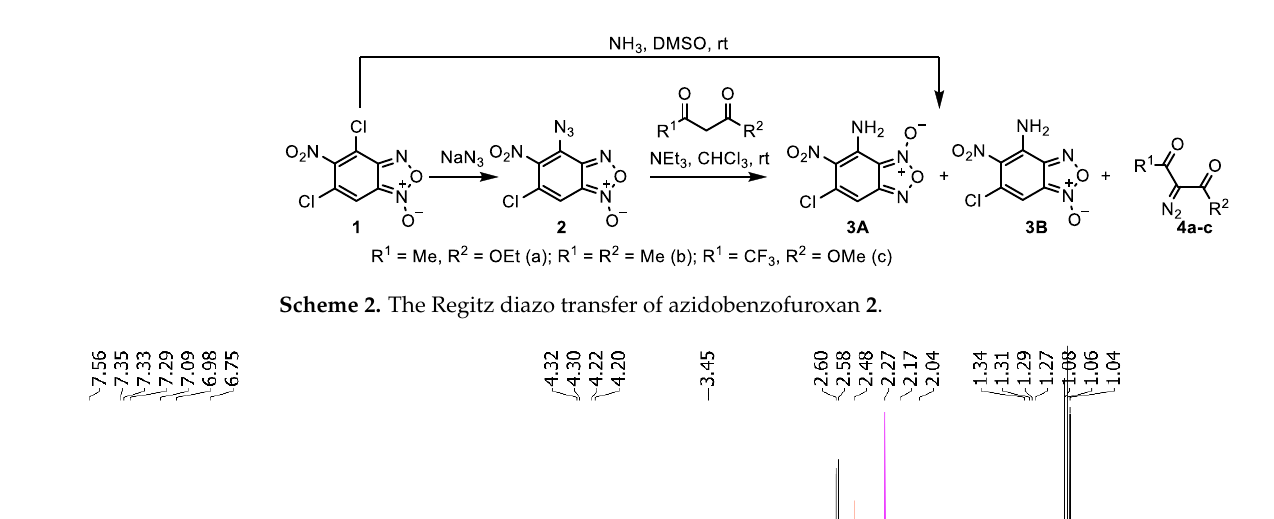
Figure 3. Asymmetric unit of tautomers 3A and 3B showing 50% probability thermal ellipsoids. C atoms: grey; N atoms: blue; O atoms: red; Cl atom: green.